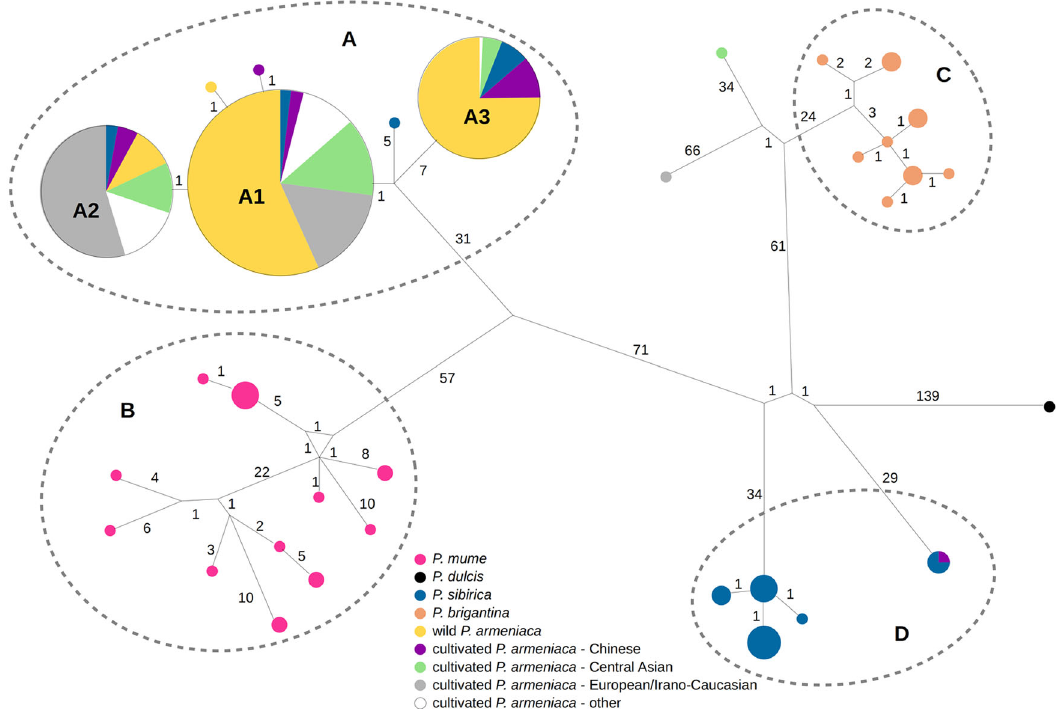
Fig. 3 Median-joining network showing the genetic relationships among Armeniaca chloroplastic haplotypes. The four main clusters are indicated as ( a ) – ( d ). Numbers under the lines indicate the number of substitutions separating two haplotypes. The taxa are colored according to the nuclear DNA- based groups (Fig. 1a and 1b). Pink: P. mume , black: P. dulcis , dark blue: wild Northern Eastern Chinese P. sibirica (NE_Psib); green: wild Western Chinese P. sibirica (NW_Psib), orange: P. brigantina , yellow: wild P. armeniaca (S_Par and N_Par); purple: cultivated Chinese apricots, light blue: cultivated Central Asian apricots, grey: cultivated European/Irano-Caucasian apricots, white: other cultivated apricots. The size of the circles indicates sample size. The two samples closer to P. brigantina correspond to interspeci fi c plum x apricot individuals (A3865 and US196, Supplementary Data 1). Source data are provided as a Source Data fi